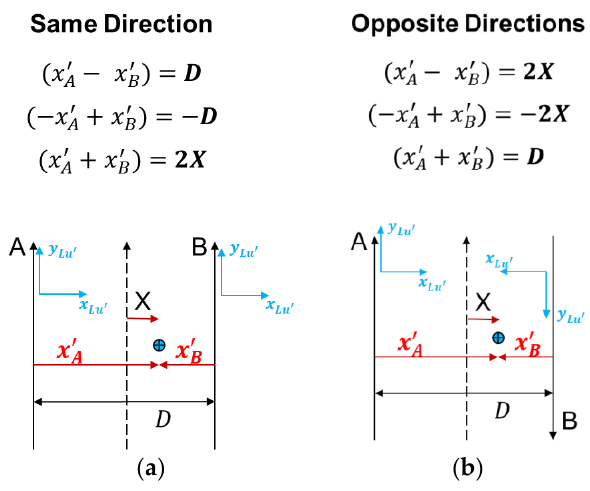
Figure 7. Relationship between 𝑥 ′ -coordinates for: ( a ) two tracks in same direction; and ( b ) two tracks in opposite directions.